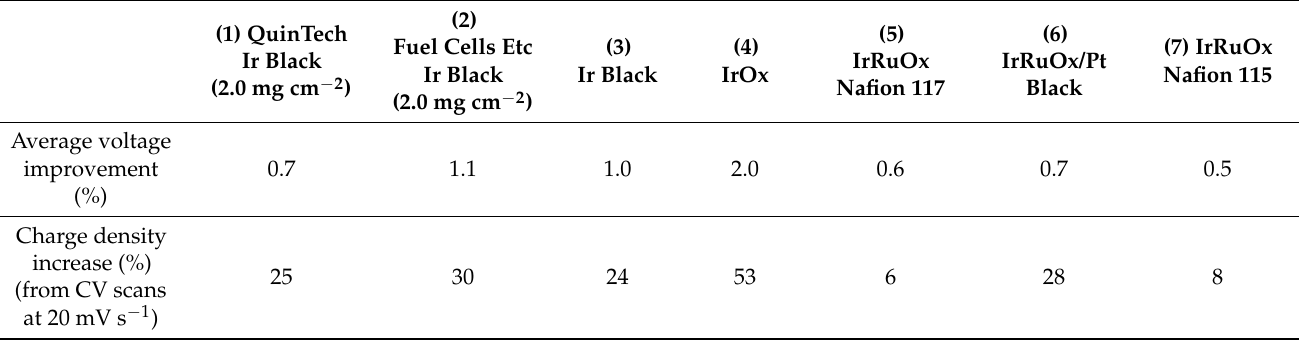
Table 2. Average temporary voltage improvement and charge density increase after hydrogen purge on